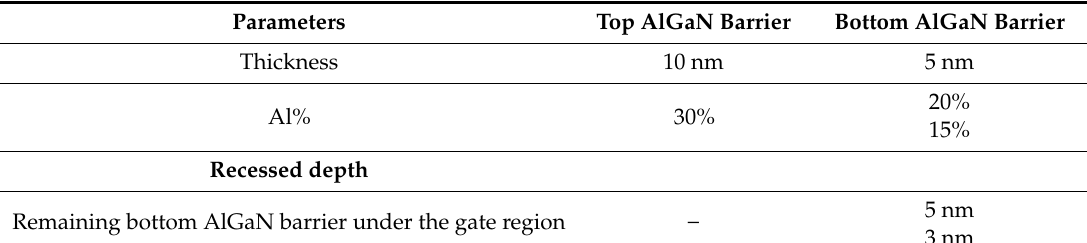
Table 1. Summary of the Varied Parameters.